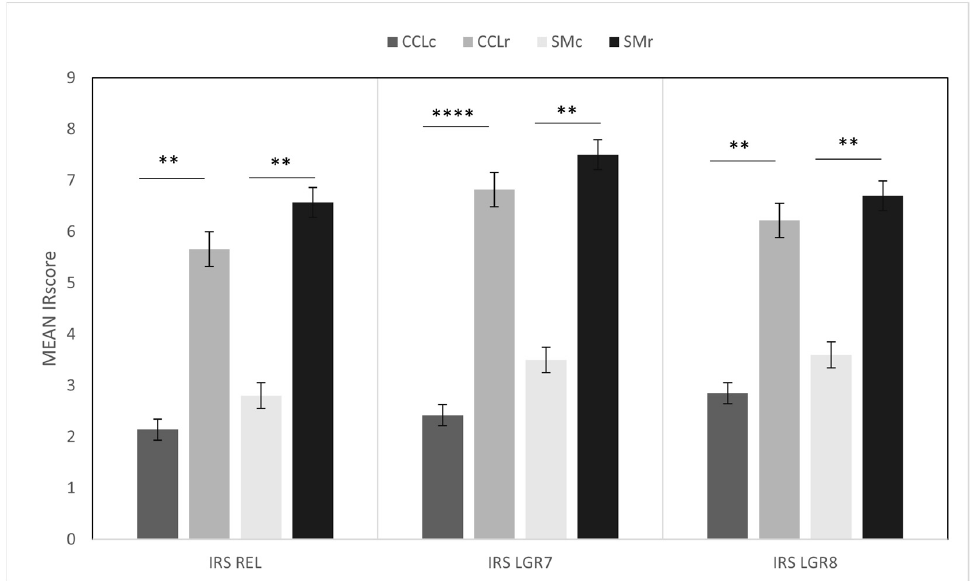
Figure 4. Bar graphs showing expression of relaxin (REL), LGR7, and LGR8 in synovial membranes and cruciate ligaments in the control group ( n = 7), SMc, and CCLc columns, respectively, and in dogs with CCLD ( n = 18), SMr and CCLr columns, respectively; values are expressed as mean immunoreactivity score (IRS) with standard error bars; significance levels of REL CCLc/CCLr p = 0.001 (**), LGR7 CCLc/CCLr p < 0.001 (****), LGR8 CCLc/CCLr p = 0.001 (**), REL SMc/SMr p = 0.02 (**), LGR7 SMc/SMr p = 0.001 (**), LGR8 SMc/SMr p = 0.003 (**).